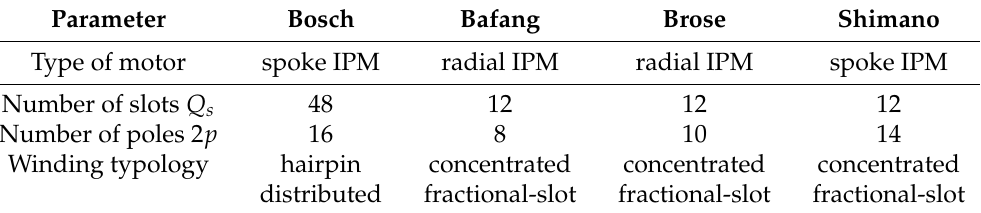
Table 2. Motor typology of different commercial PM machines.